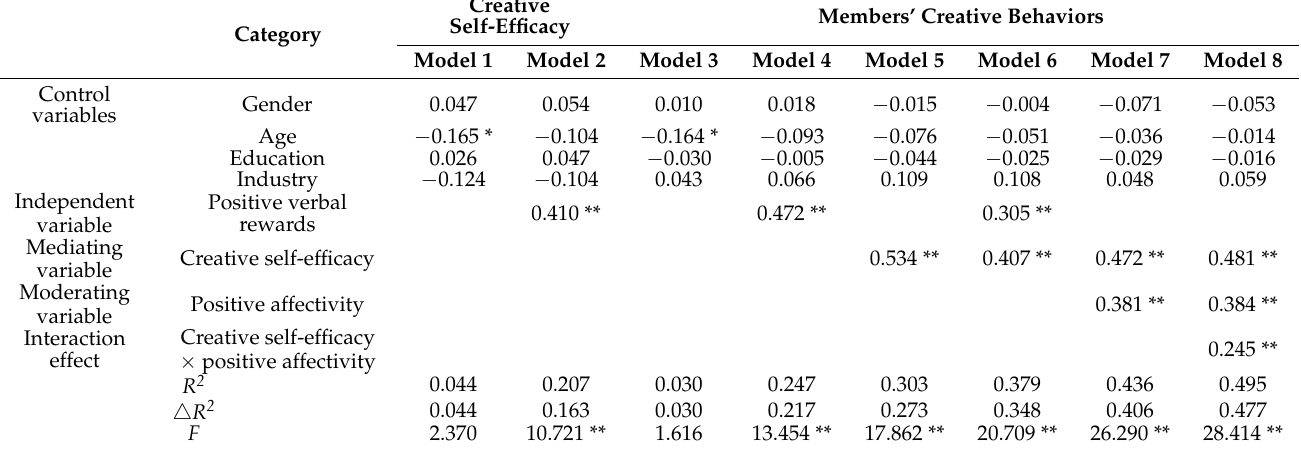
Table 4. Hypothesis test